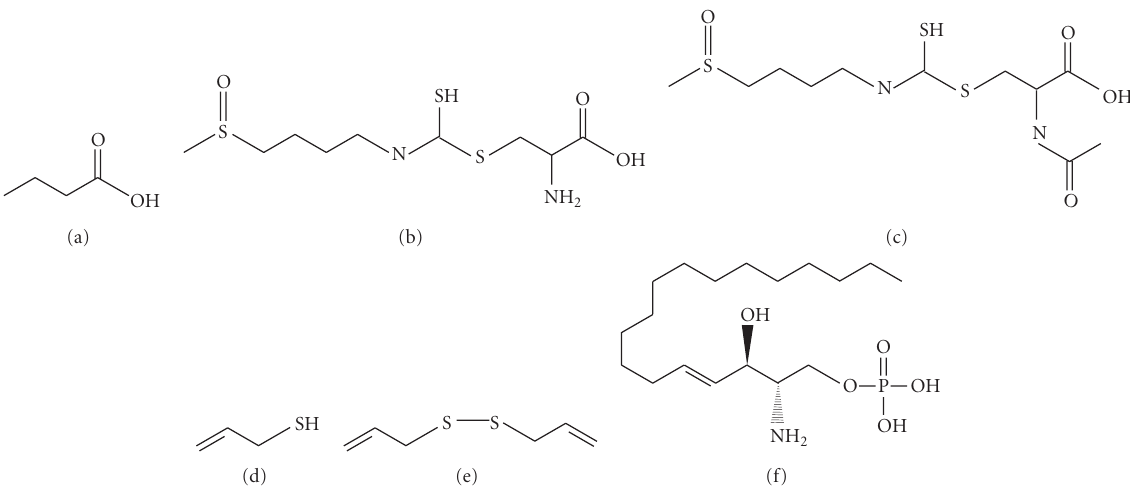
Figure 4: Chemical structure of dietary and endogenous inhibitors of HDACs. (a) butyric acid, acid form of butyrate, a product from dietary fiber fermentation by gut bacteria; (b, c) sulforaphane cysteine and sulforaphane N -acetyl-cysteine from cruciferous vegetables; (d, e) allyl mercaptan and diallyl disulfide from garlic; and (f) sphingosine-1-phosphate [62–64]. These compounds are either naturally or endogenously occurring, and they act on di ff erent members of the Rpd3/Hda1 family. The structures may be used as templates to generate more specific compounds with higher specificity and e ffi